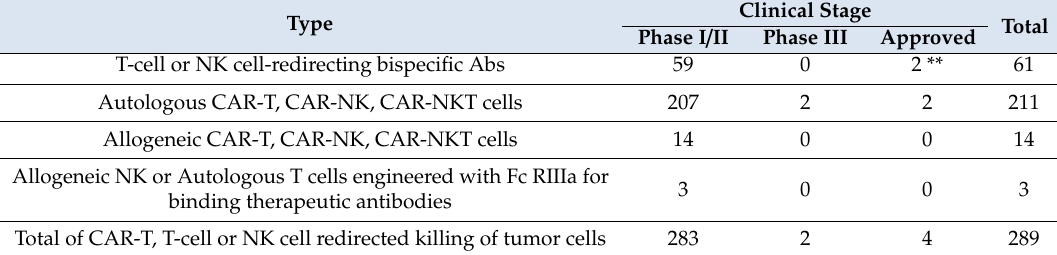
Table 1. Overview of T-cell and NK-cell redirected therapeutics in clinical trials *.